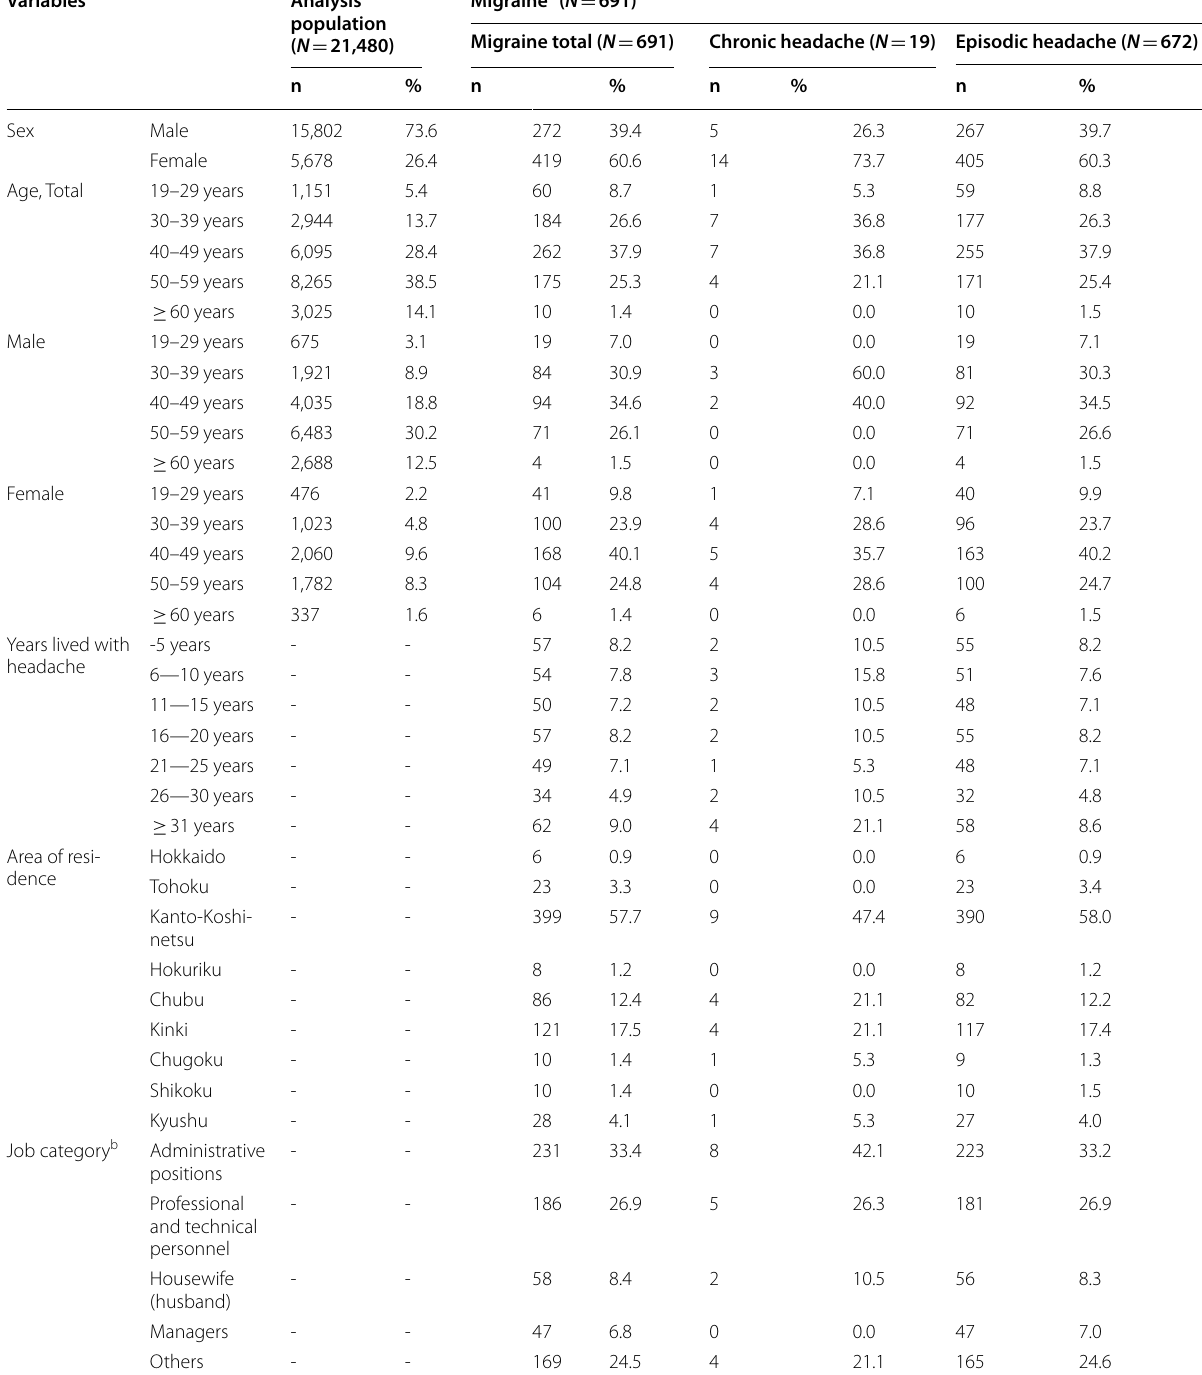
Table 1 Characteristics of people with migraine